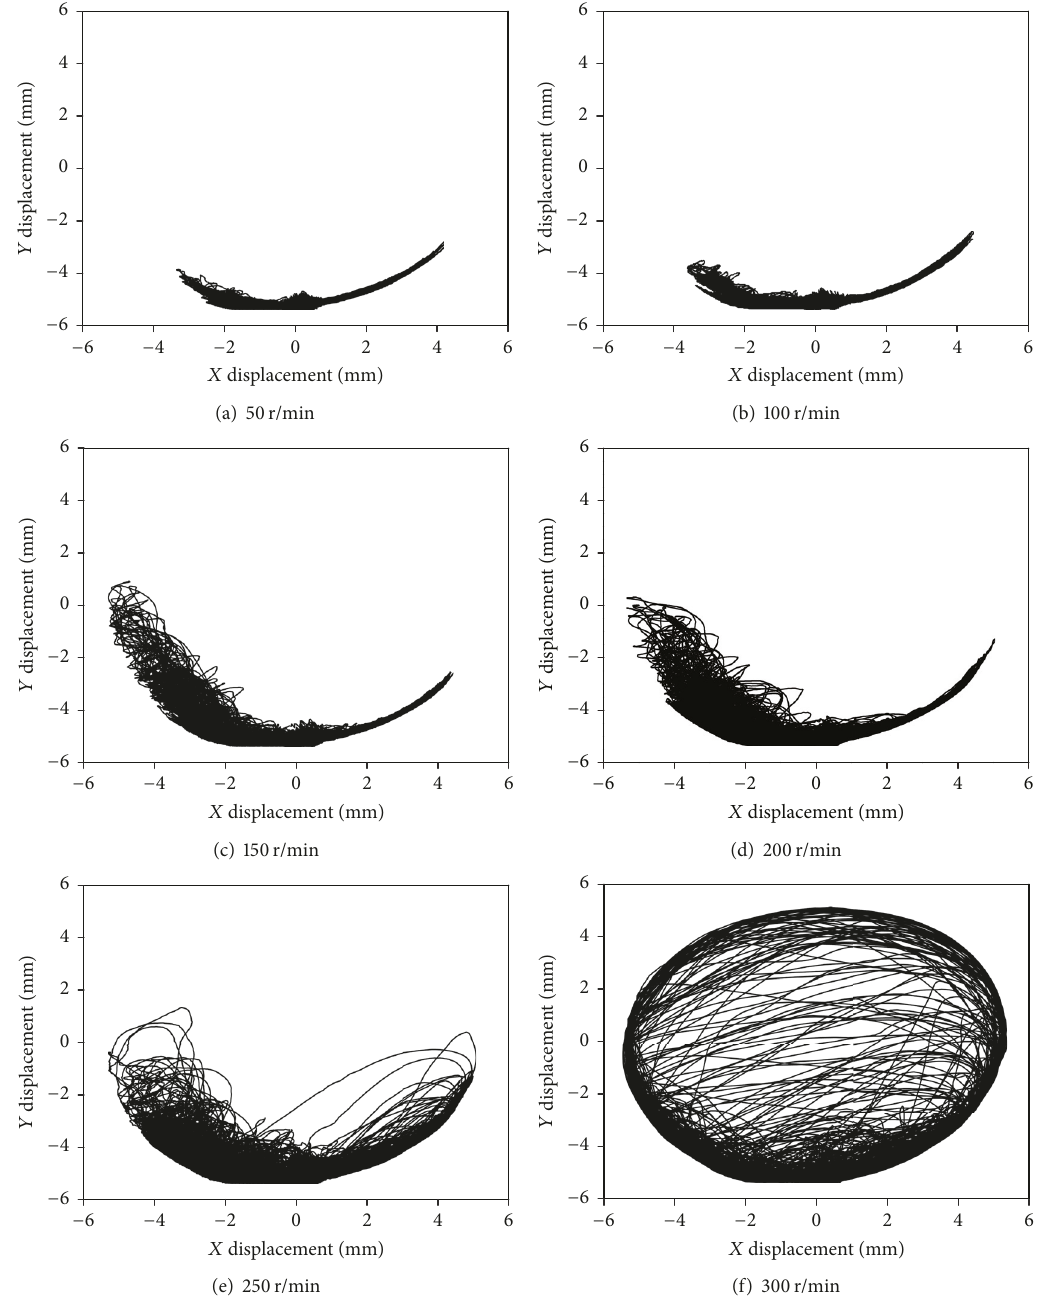
Figure 12: Axis trajectory of the dynamic buckling at different speeds